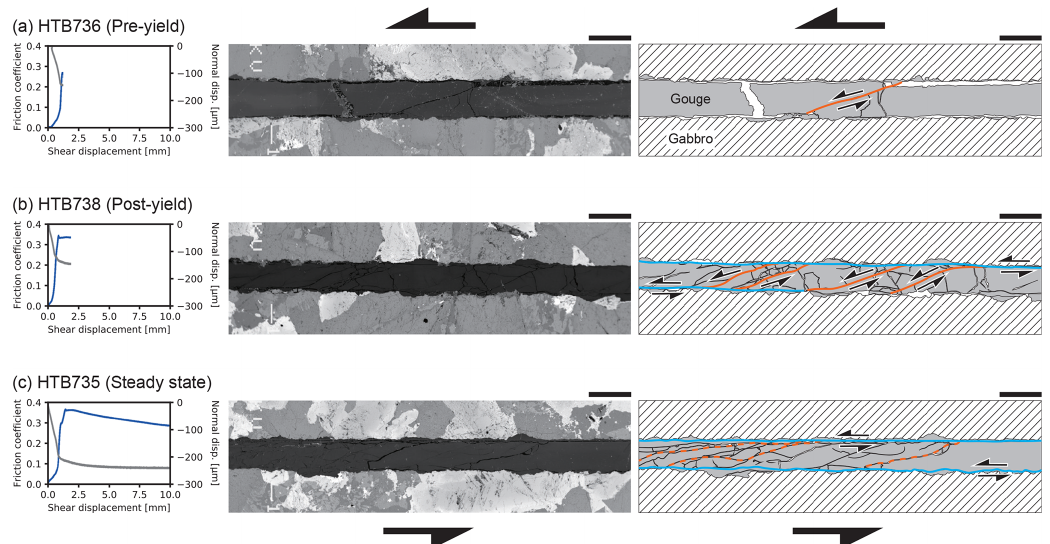
Figure 6. Backscattered electron (BSE) images showing the deformation of gouges (center) and corresponding interpretive sketches (right) of the wet experiments. See Fig. 5 for